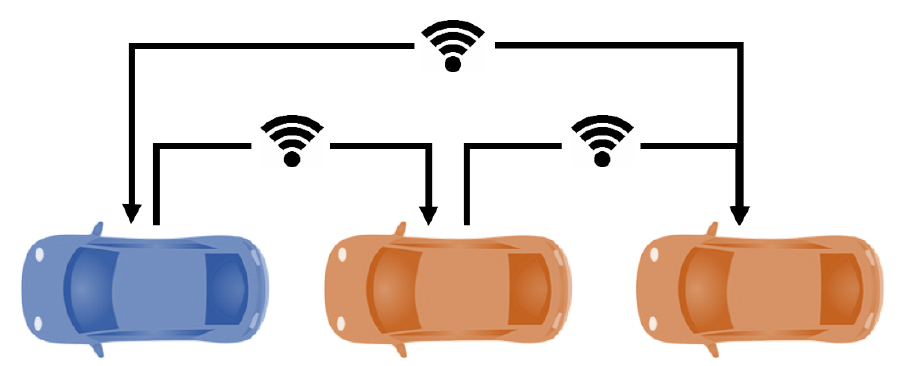
Figure 3. Platoon